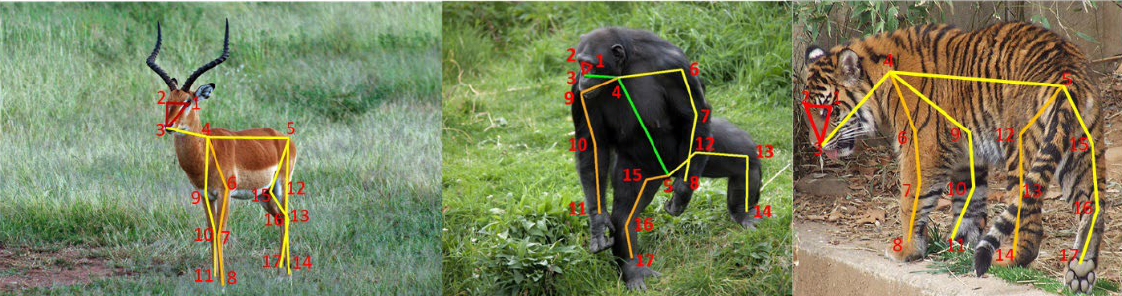
Figure 9. The keypoints of the quadruped